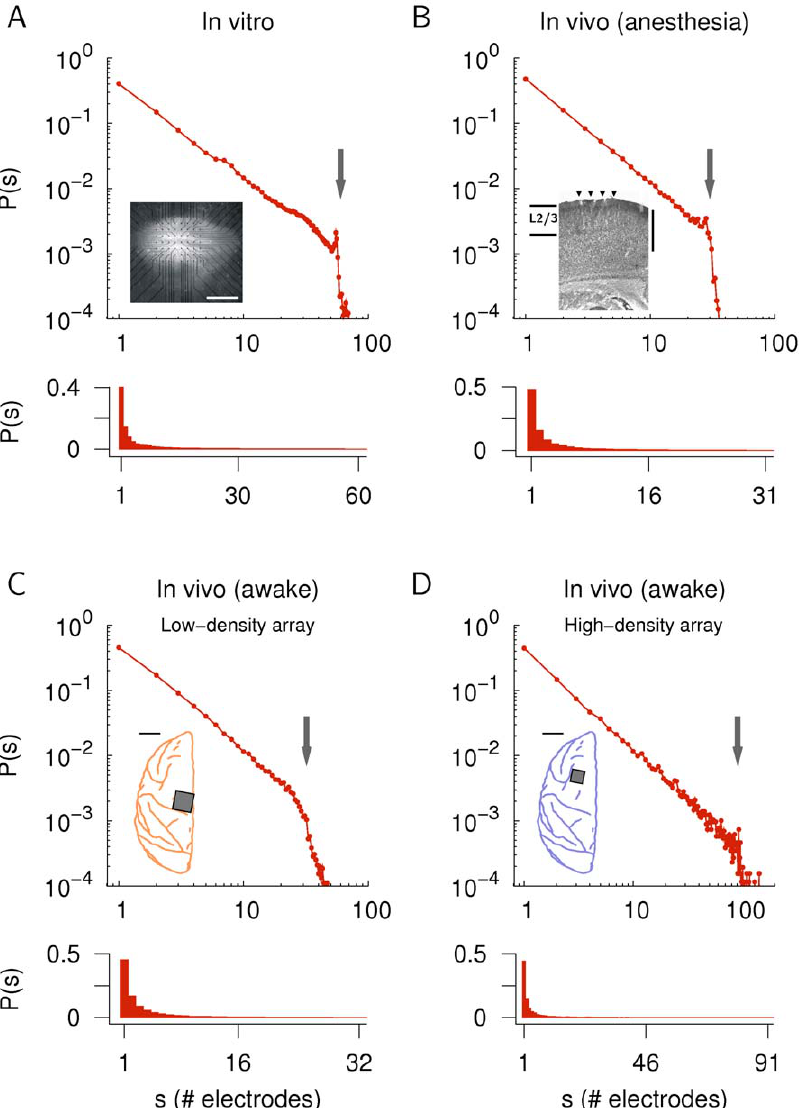
Figure 1. Avalanche size distributions analyzed in the present study. A. Average in vitro cluster size distribution in organotypic cortex slice cultures (60 electrodes, 7 cultures, n =53,443 avalanches on average) in double-logarithmic (upper panel) and linear scale (lower panel). The data set was taken from [2]. Inset: view of a culture on a 8 | 8 electrode array (scale bar, 1 mm). B. Average in vivo cluster size distribution from rat somatosensory cortex under urethane anesthesia (27–31 electrodes, 7 recordings, n =22,321 avalanches on average). Data was taken from [4]. Inset: view of the insertion sites for an 8 | 4 array (triangles) in cortical layer 2/3 (vertical scale bar, 1 mm). C. 43-min recording for monkey X (low-density microelectrode array with 32 electrodes in the left primary motor cortex, n =45,574 avalanches). Data was taken from [5]. D. 30-min recording for the second monkey (monkey Y, high-density microelectrode array with 91 electrodes in the left premotor cortex, n =24,877 avalanches). Insets in C and D show the location of the multielectrode arrays (scale bar, 10 mm). The size of the arrays (dark squares) is not shown in the actual scale. The number of electrodes in the individual arrays is indicated by arrows in the log-log plots (A–D).